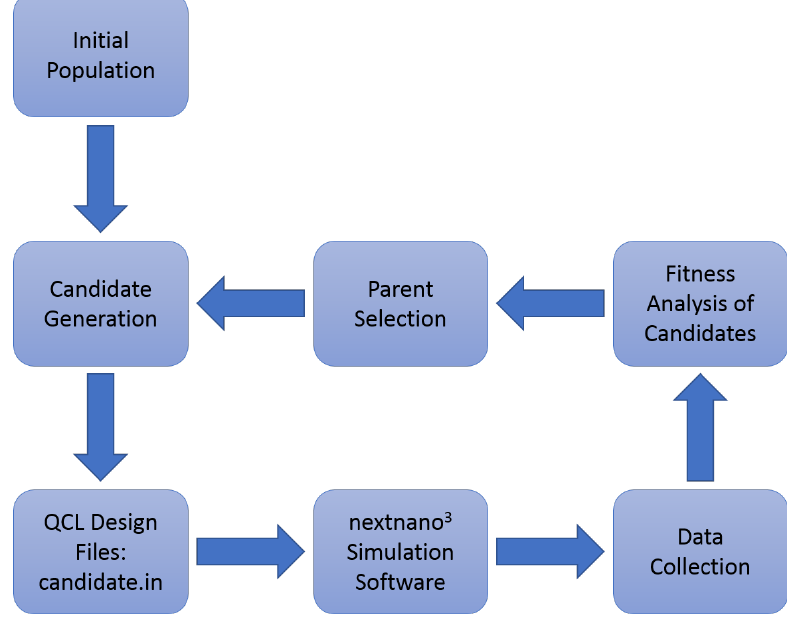
Figure 1. General flow diagram of the evolutionary algorithm used in this